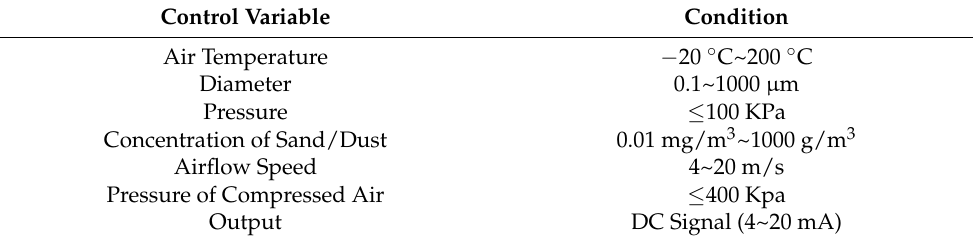
Table 1. Technical index of EMP7-3270 dust concentration on-line